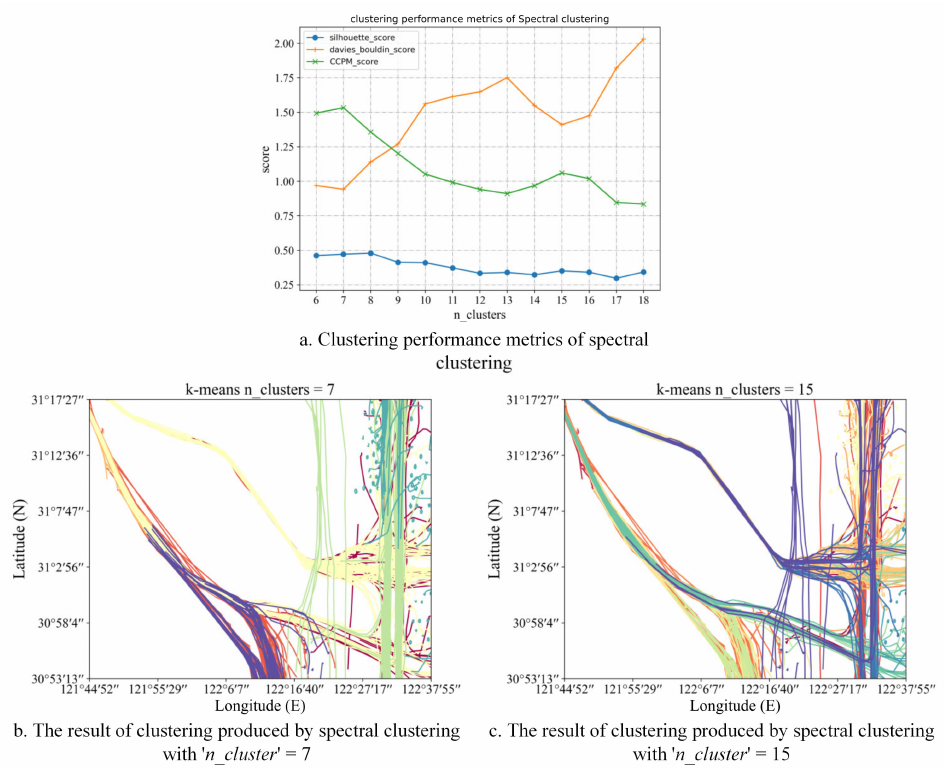
Figure 11. Clustering performance of spectral clustering method with different configurations.